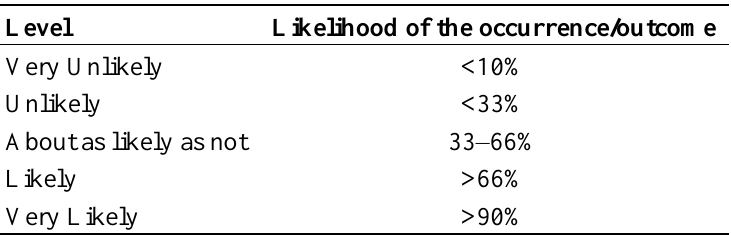
Table 2. Likelihood